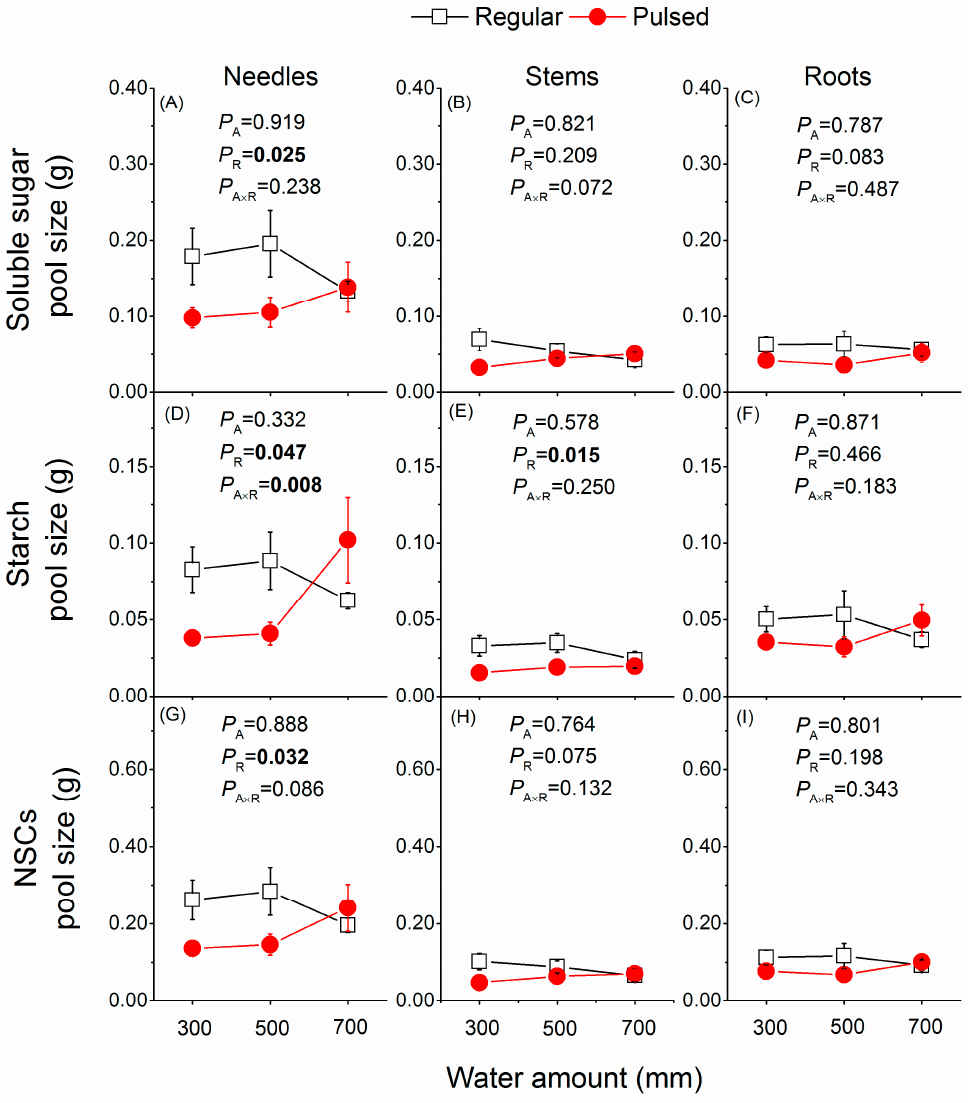
Figure 5. Effects of the watering regime (regular vs. pulsed) and water amount (300, 500, and 700 mm) on pool size of soluble sugars ( A – C ), starch ( D – F ), and NSCs ( G – I ) in different tissues of P. massoniana saplings. p values of two-way ANOVAS are given. A and R represent water amount and watering regime, respectively. Plotted are means ± SE.